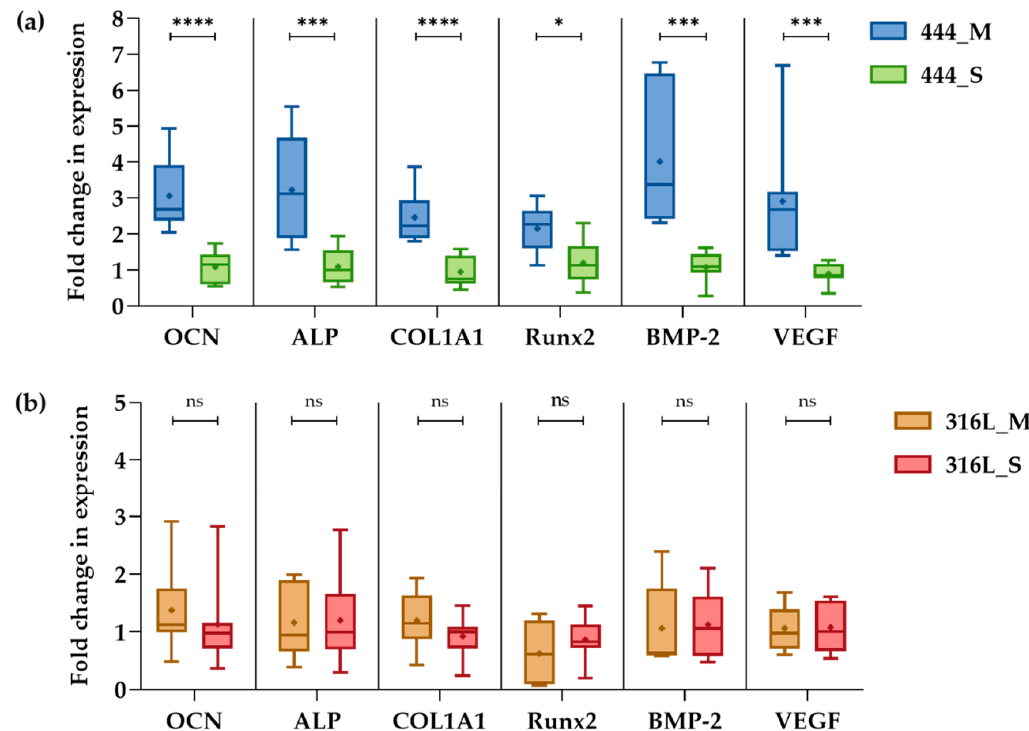
Figure 6. RT-PCR analysis of osteogenic gene expression of human osteoblasts after 21 days of culture for ( a ) 444 and ( b ) 316L fiber networks. The networks were cultured statically for 7 days followed by a daily actuation for 14 days using a magnetic field varying from 0.3 to 1.1 Tesla at a frequency of 0.2 Hz for 5 h. Boxes show interquartile ranges, horizontal lines within the boxes indicate the median, + shows the mean and whiskers denote minimum and maximum values ( n = 3, 3 samples for each group per experiment). Data are reported in an x-fold expression of static cultures. Statistical analysis was conducted by unpaired t test, * p < 0.05, *** p < 0.001, **** p < 0.0001, ns: no statistical significance. Osteocalcin, OCN ; alkaline phosphatase, ALP ; collagen type 1 α 1, COL1A1 ; runt-related transcription factor 2, Runx2 ; bone morphogenetic protein 2, BMP-2 ; vascular endothelial growth factor, VEGF .